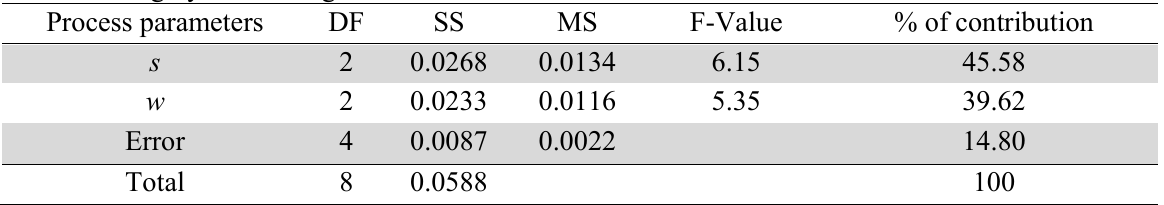
ANOVA for grey relational grade Process